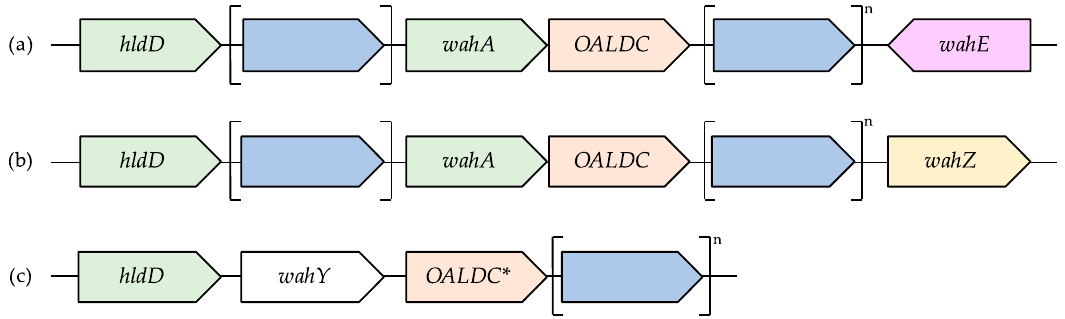
Figure 3. Schematic description of the different Aeromonas wa Region 1 types reported. ( a ) The gene hldD was found at the start of the wa Region 1 in all Aeromonas species. In A . salmonicida , a glycosyltransferase-coding gene (in blue) is present between hldD and wahA . A gene coding for an O-antigen ligase domain-containing was always found next to wahA , followed by a variable number of hypothetical genes and glycosyltransferases, and, finally, wahE ; ( b ) Most of the species of the A . veronii monophyletic group present the same genomic architecture but with wahZ instead of wahE ; and ( c ) In the species in which genome wahA is not present, wahY is found next to hldD , followed by a gene coding for an O-antigen ligase domain-containing protein (except in the species described above where this gene is found in the wa Region 2, marked with an asterisk) and a variable number of glycosyltransferases and hypothetical proteins. OALDC = O-antigen ligase domain containing gene.